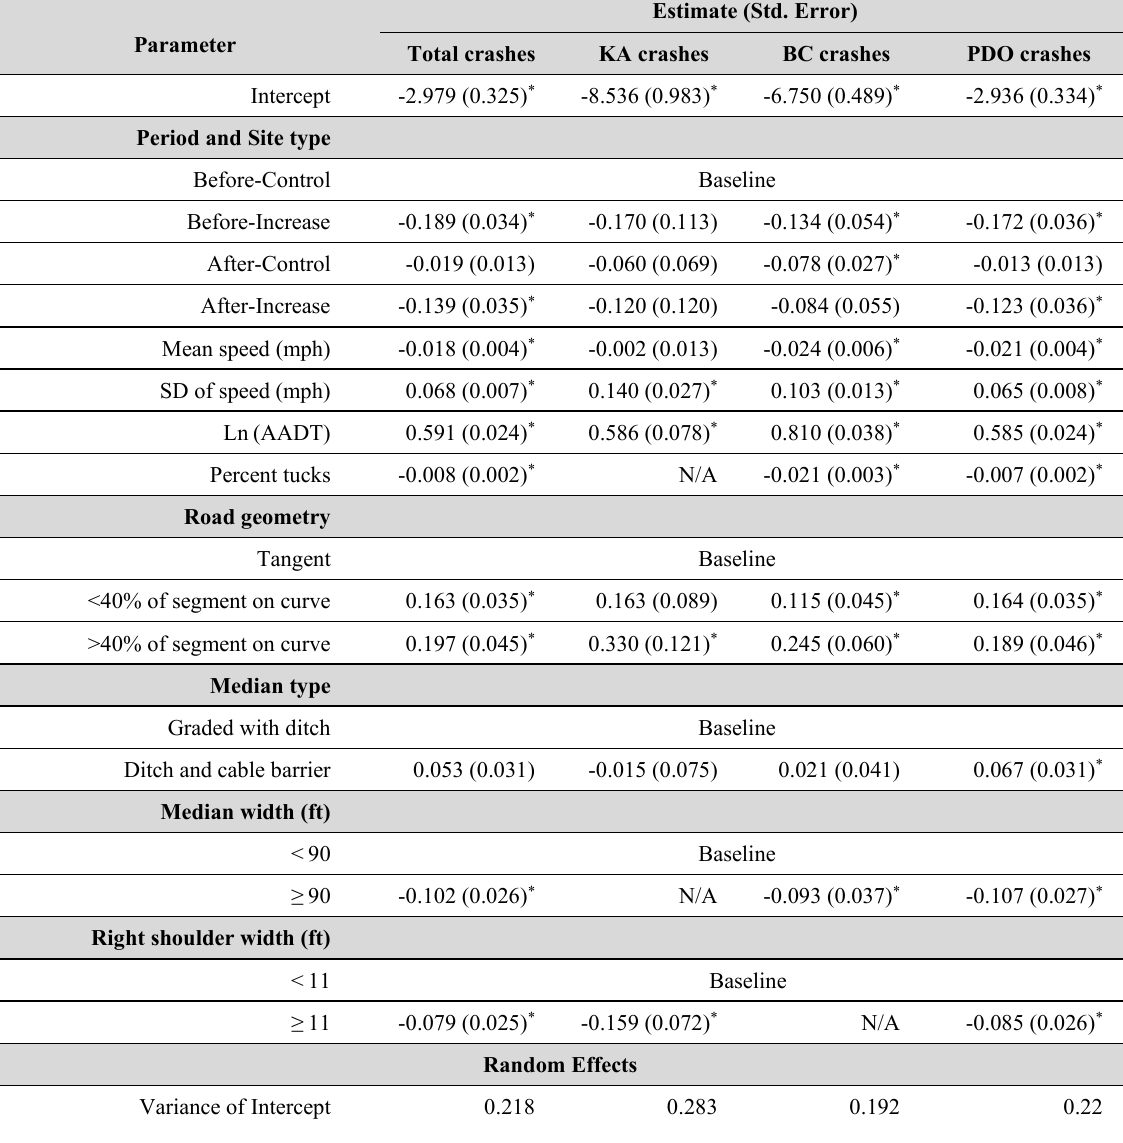
Table 2 Random effects negative binomial parameter estimates based on crash